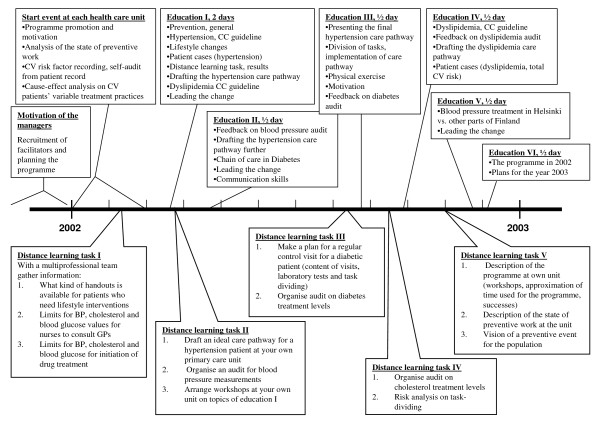
Description of the intervention during the year 2002. Abbreviations: CV, cardiovascular; CC, Current Care; GP, general practitioner; BP, blood pressure.